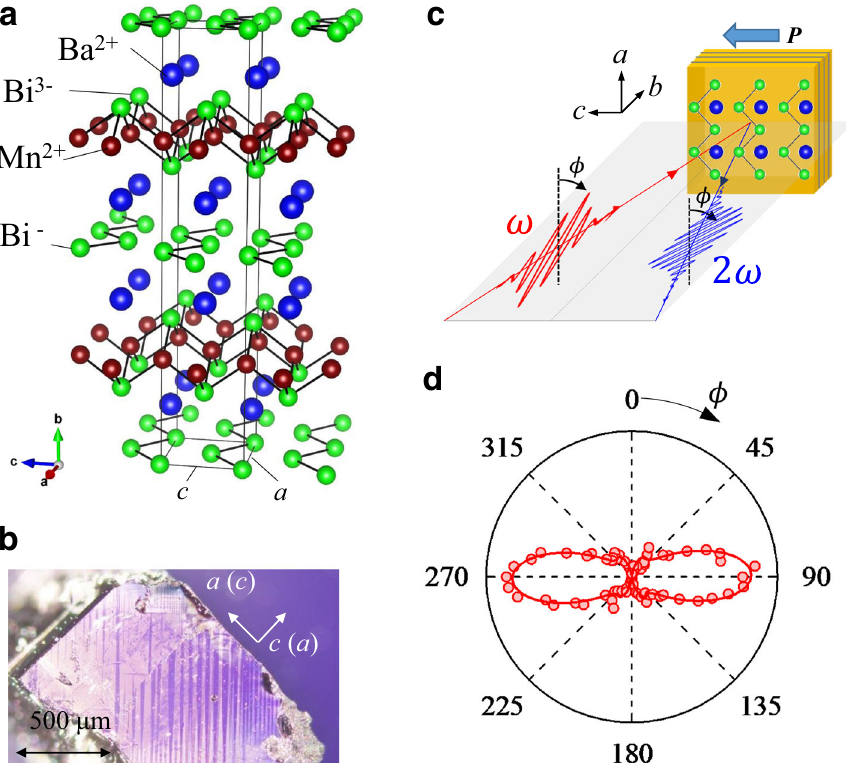
Fig. 1 Polar crystal structure and optical properties of BaMnBi 2 . a Crystal structure determined from single-crystal X-ray diffraction at 100 K. b The polarized microscope image of the as-grown crystal surface. c Schematic image of the SHG measurement at nearly normal incidence (~1 ∘ ). The angle ϕ denotes the polarization of the incident fundamental light ( ω ) and the emitted SHG light (2 ω ). d Polarization analysis of the SHG signal with a fi tting (red solid curve) assuming mm 2 symmetry. All the measurements were performed at room